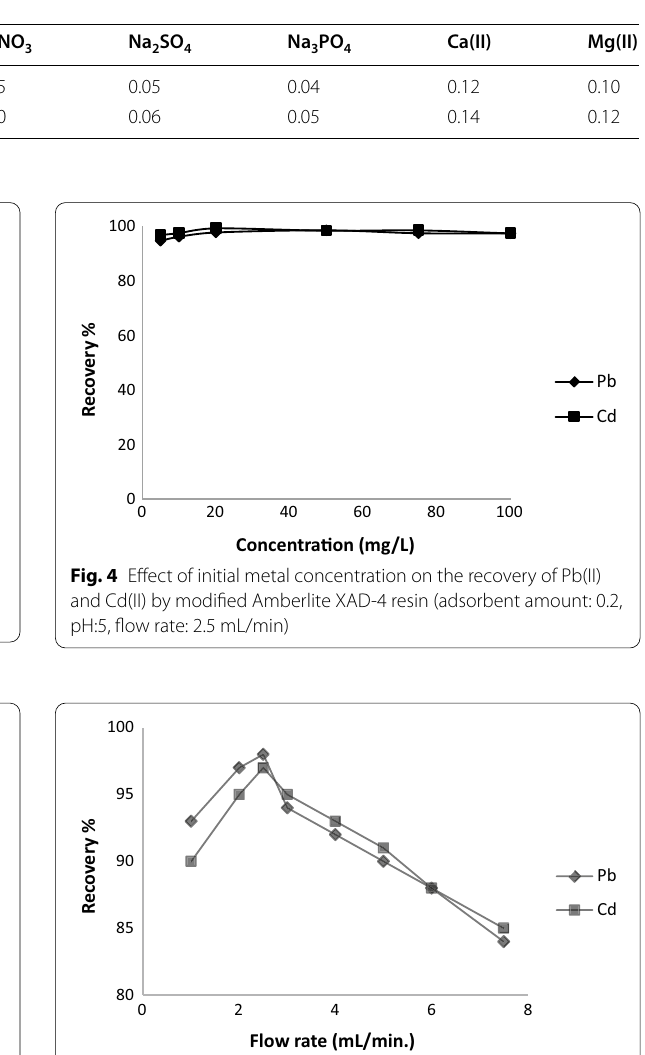
Fig. 3 Effect of amount of adsorbent on the recovery of Pb(II) and Cd(II) by modified Amberlite XAD-4 resin (pH:5, initial metal concentration: 20 mg/L, flow rate: 2.5 mL/min)